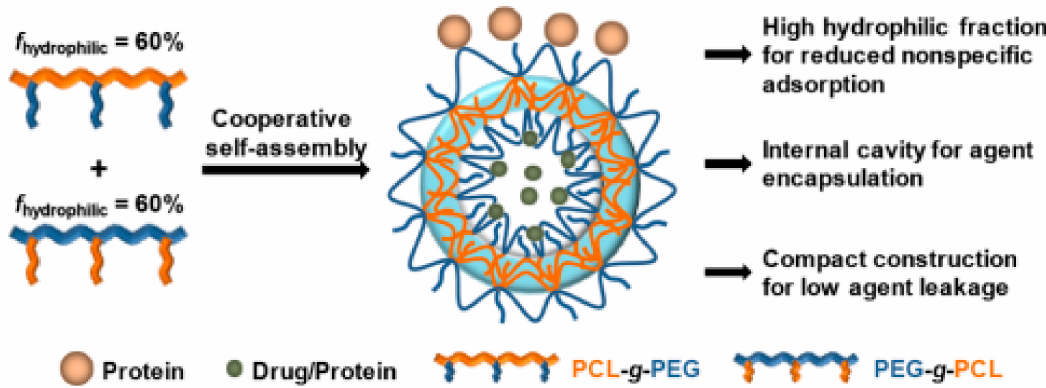
Scheme 7. Graphical representation of compact vesicle preparation composed of binary graft copoly- mers with high hydrophilic segment content for drug and protein delivery applications. Reprinted with permission from Ref. [108]. Copyright 2017, American Chemical